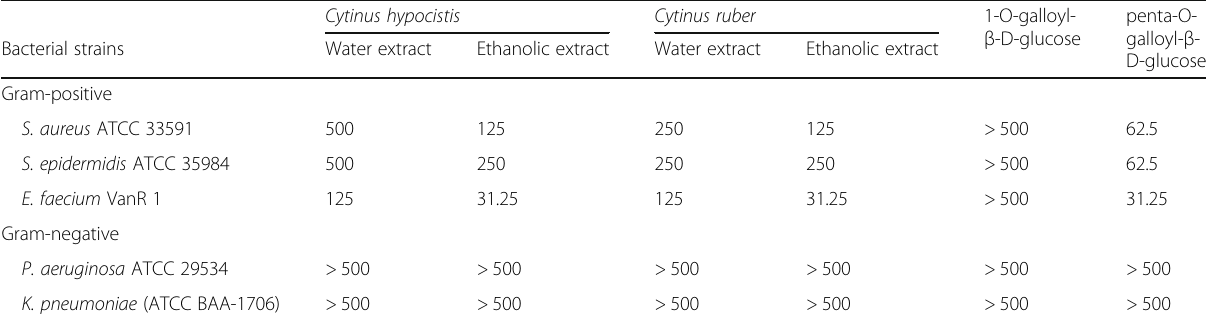
Table 4 Antimicrobial activities of water and ethanolic extracts of Cytinus against Gram-positive and Gram-negative